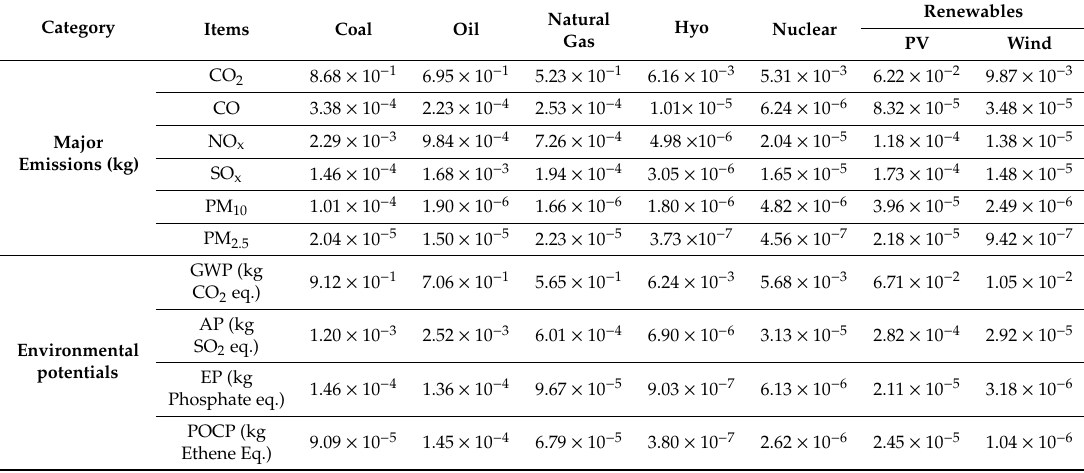
Table 4. Key emission factors associated with various energy sources for electricity generation (Unit: /1kWh electricity production).